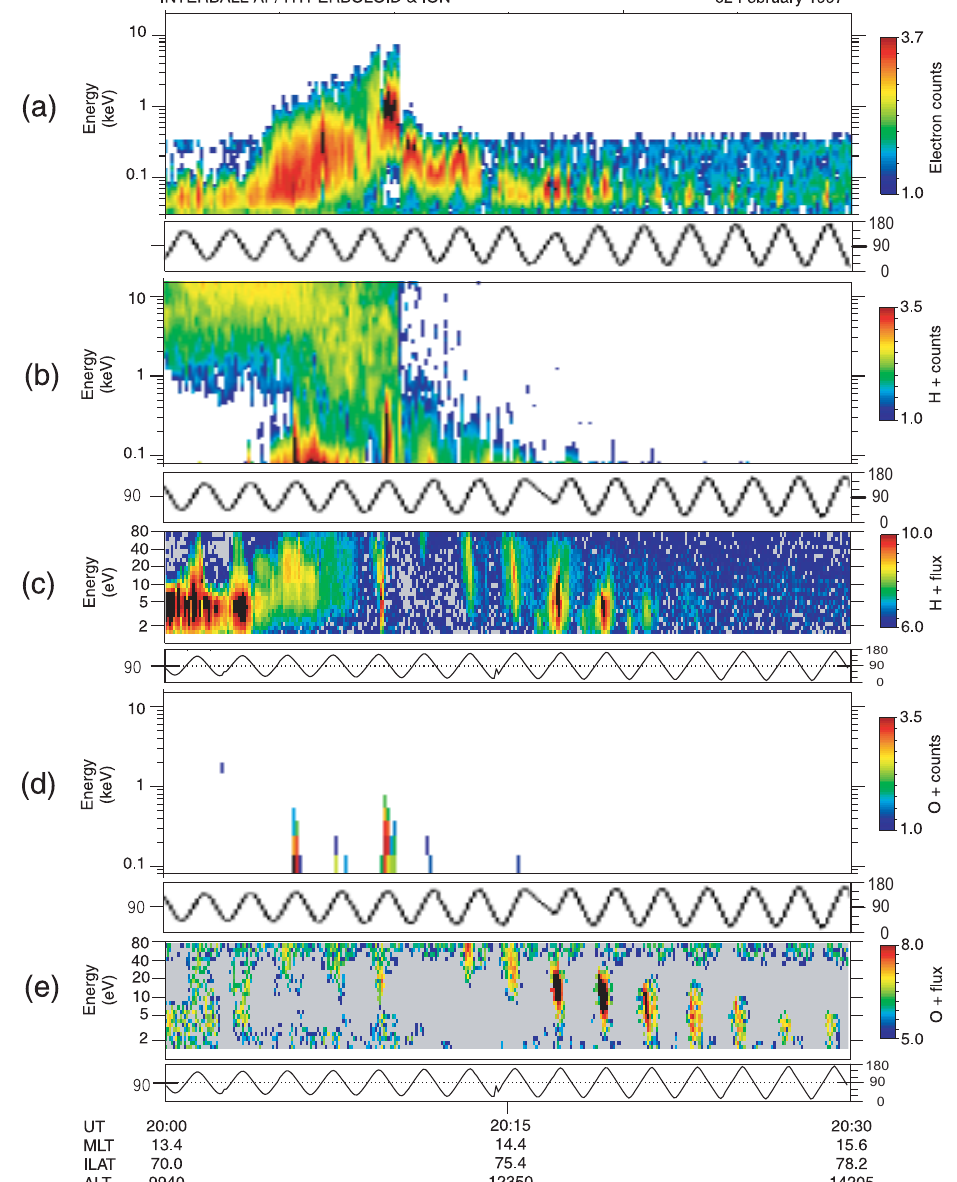
Fig. 3. Overview of a crossing of field-aligned potential drops on 9 February 1997, between 20:00 and 20:30 UT. The format is the same as for Fig.